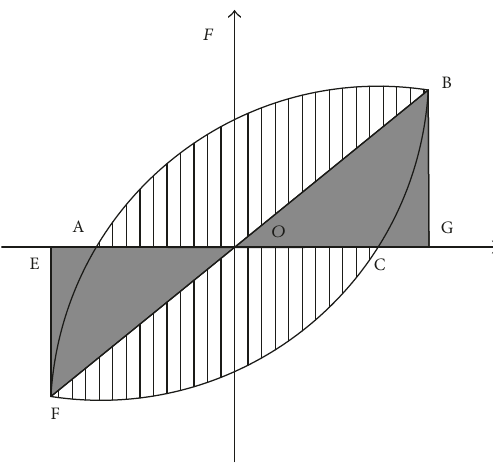
Figure 10: The dissipation capacity area.